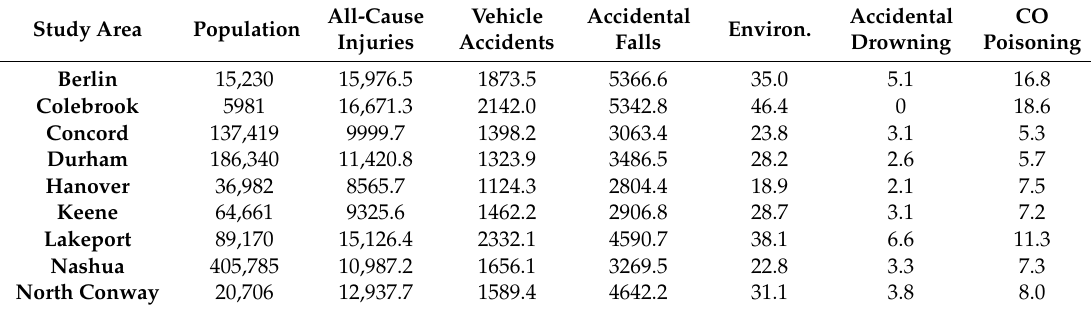
Table 4. Annual injury rates per 100,000 people across all study